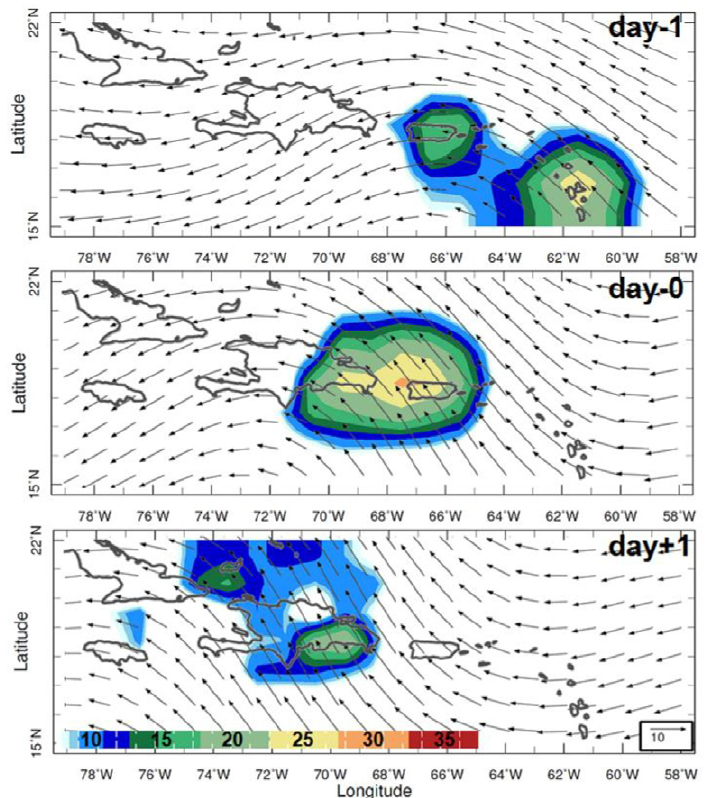
Figure 9. Maps of composite easterly wave rainfall (mm / day) and 1000–500 hPa layer winds over a 3-day period (top-down) with scales in the lower panel; based on dates in Table 3.